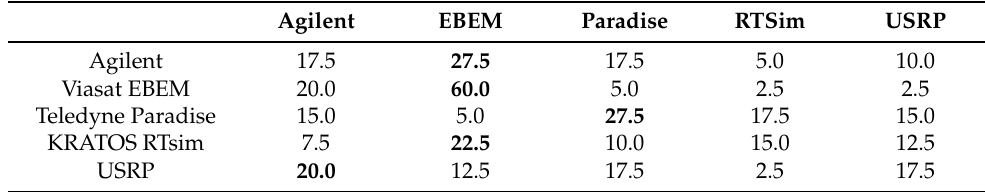
Table 5. Same as Table 3 @ SNR = 0